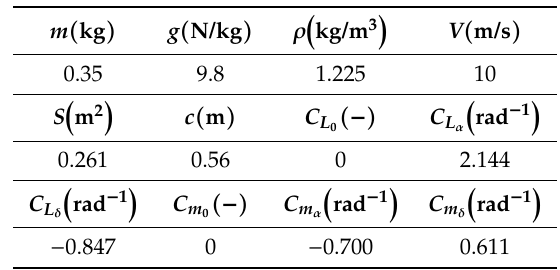
Table 5. Parameters used to solve the trim problem: flight conditions, cloth geometry, and aerodynamic coe ffi cients obtained from